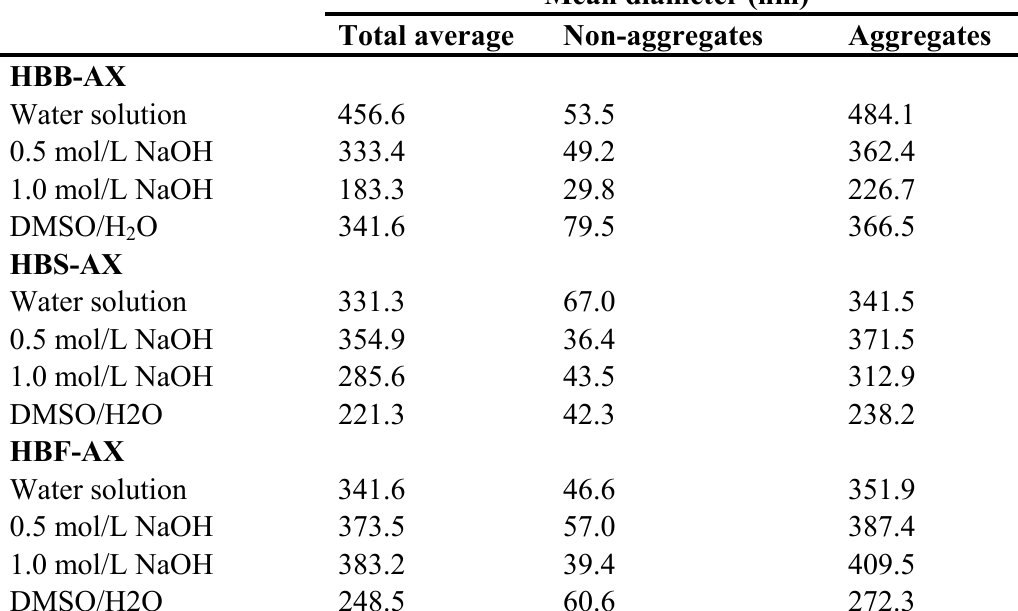
Table 4. Dynamic light scattering results of HBB-AX, HBS-AX and HBF-AX in different